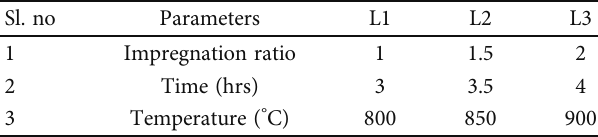
Table 1: BBD constraints and their levels. Sl.